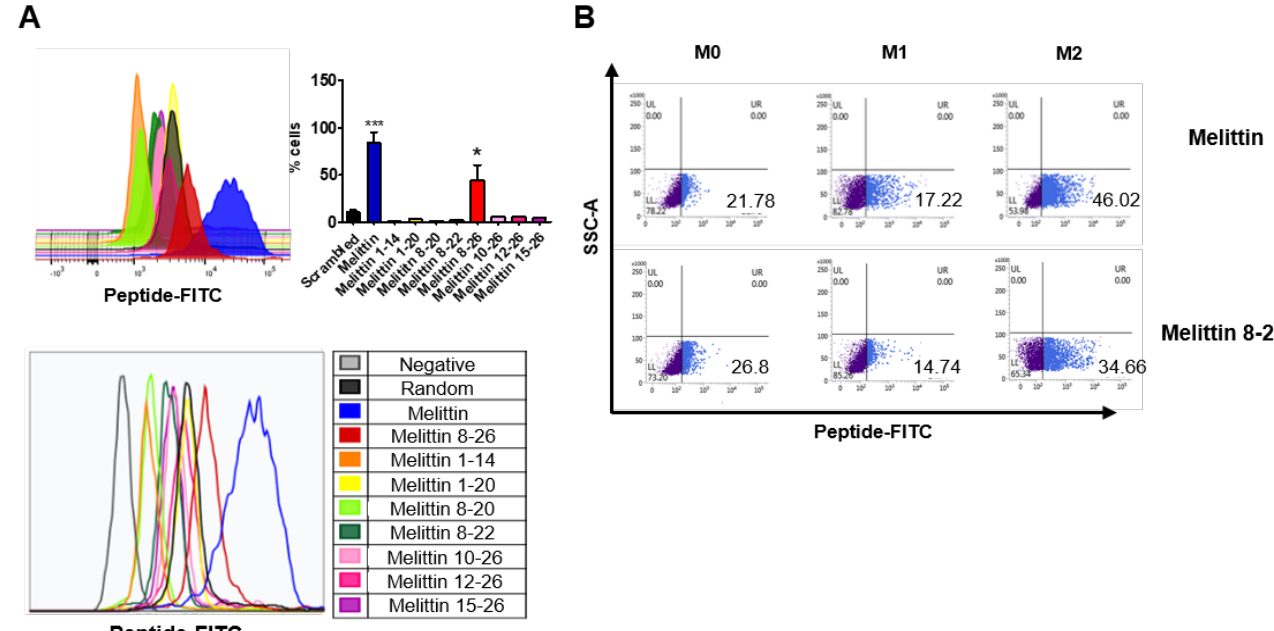
Figure 3. Binding of melittin fragments to the THP-1-derived M2 macrophages. Human monocyte THP-1 cells were stimulated with 100 nM PMA for 24 h and polarized into M1 macrophages using 100 ng/mL LPS and 20 ng/mL IFN- γ and into M2 macrophages using 20 ng/mL IL-4 and 20 ng/mL IL-13. Cells were incubated with FITC-conjugated melittin or FITC-conjugated melittin fragments (100 nM) at 37 °C for 1 h. ( A ) Melittin or melittin fragment affinity for M2 macrophages was measured using flow cytometry. All data are presented as the mean ± SEM; * p < 0.05, *** p < 0.001 versus the scrambled peptide (n = 3). ( B ) The affinity of melittin or melittin 8-26 for macrophages was detected by flow cytometry.